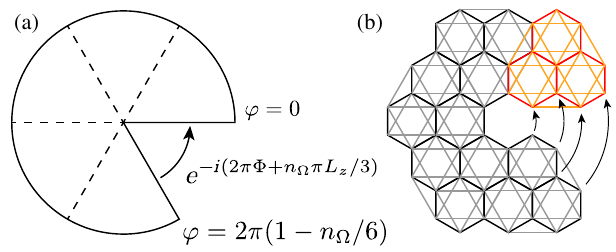
FIG. 6. (a) Schematic illustration of the construction of dis- clinations. (b) An example of our setup in numerical calculations.